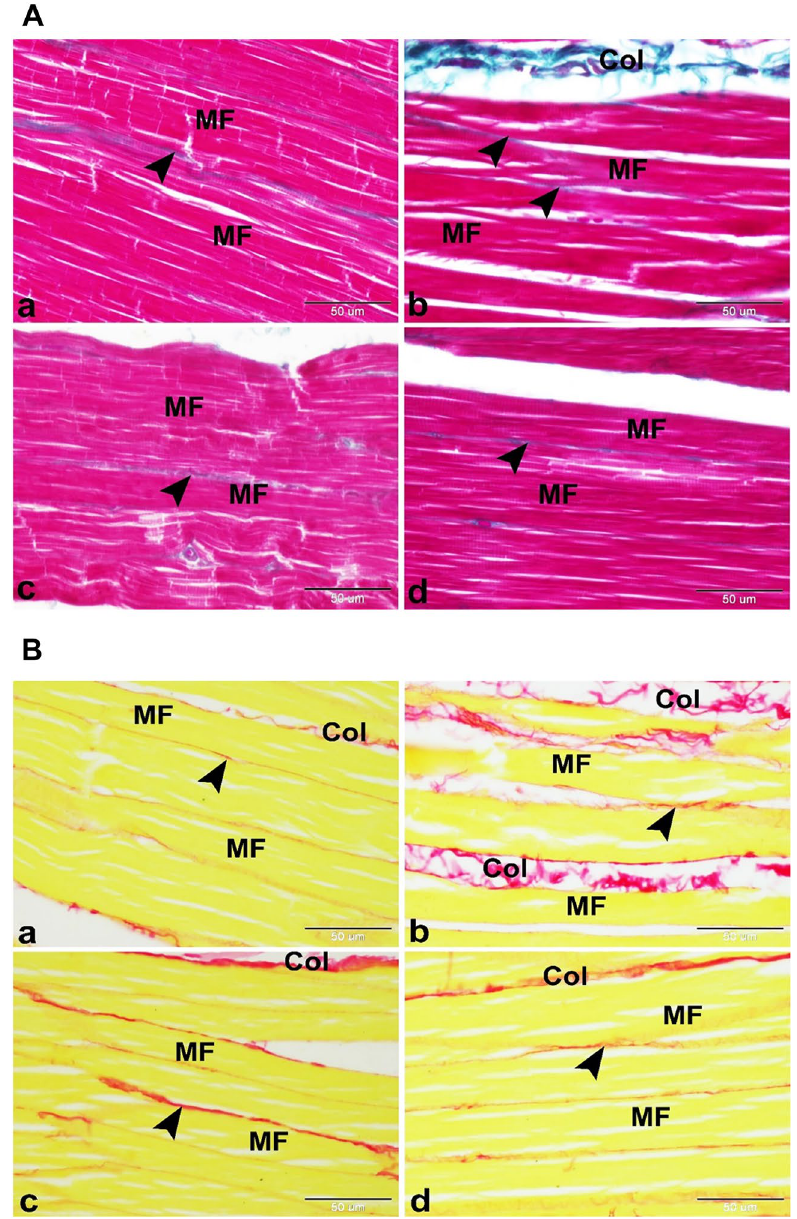
Figure 3. ( A ) Photomicrographs showing minimizing of the myotoxic side effects of SV by using microsponges formulations in rats. ( a ) Control group showing the normal architecture of the skeletal muscle in rat. The skeletal muscle was formed of several parallel elongated cylindrical muscle fibers (MF) with few amounts of collagen fibers in the endomysium and perimysium. ( b ) Free SV group showing the myotoxic side effects of SV as increased amounts of collagen fibers in the endomysium (arrowhead) and perimysium (Col) which surround the muscle fibers (MF). ( c ) FSV-6 group showing few amounts of collagen fibers in the endomysium and perimysium (arrowhead) which surround the muscle fibers (MF). ( d ) FSV-1 group showing minimizing of the myotoxic side effects of SV. The skeletal muscle was formed of several parallel elongated cylindrical muscle fibers (MF) with few amounts of collagen fibers in the endomysium and perimysium (arrowhead). Masson’s trichrome, scale bar = 50 μm. ( B ) Photomicrographs showing minimizing of the myotoxic side effects of SV by using microsponges formulas in rats. ( a ) Control group showing several parallel elongated cylindrical muscle fibers (MF) with few amounts of mature collagen fibers in the endomysium (arrowhead) and perimysium (Col). ( b ) Free SV group showing the myotoxic side effects of SV as increased amounts of mature collagen fibers in the endomysium (arrowhead) between muscle fibers (MF) and perimysium (Col) surround muscle bundles. ( c ) FSV-6 group showing slight decrease in amounts of mature collagen fibers in the endomysium (arrowhead) between muscle fibers (MF) and perimysium (Col) surround muscle bundles. ( d ) FSV-1 group showing few amounts of mature collagen fibers in the endomysium (arrowhead) between muscle fibers (MF) and perimysium (Col) surround muscle bundles. Sirius red, scale bar = 50